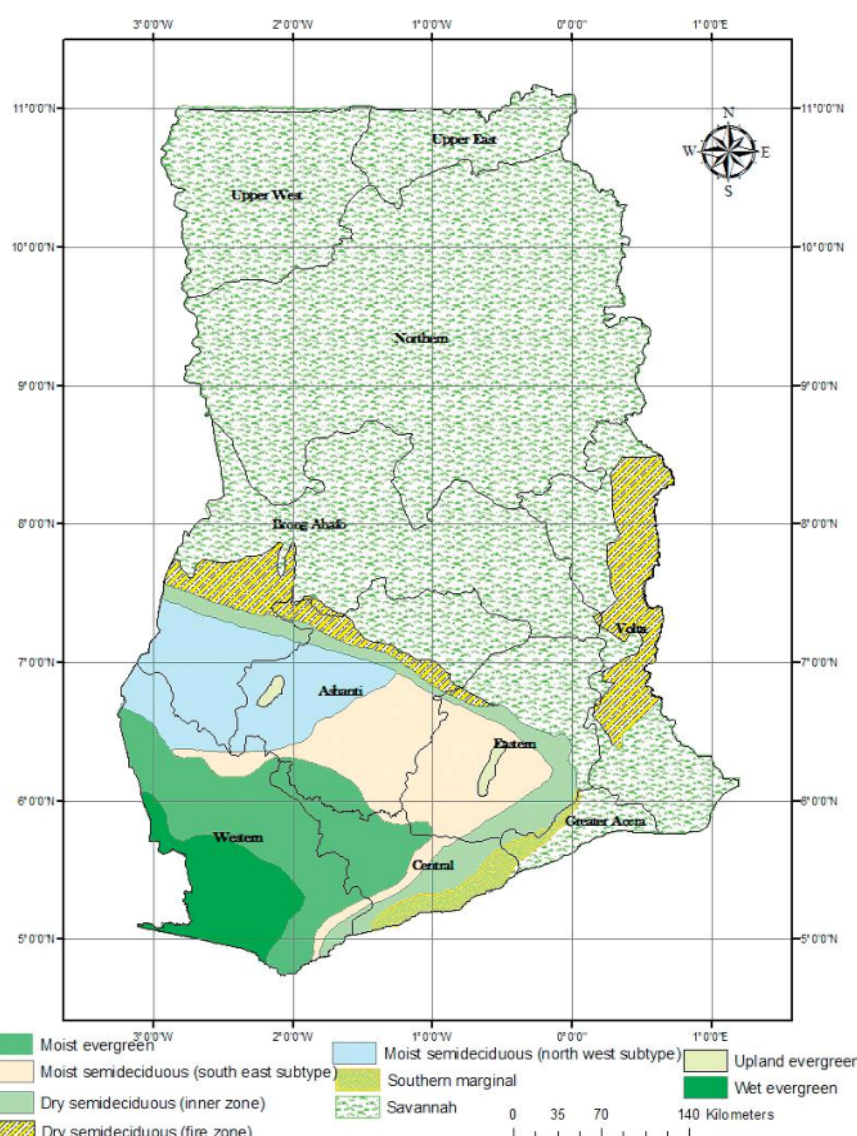
Figure 1. Map of Ghana showing the vegetation cover of high forest and savanna zones of Ghana. Source: Ghana’s high forests: trends, scenarios and pathways for future developments. Accessed on (https://www.semanticscholar.org/paper/Ghana’s-high-forests-%3A-trends%2C-scenarios-and-for-Oduro/56f6633ef23edbc1340f85365bf622c395ef533d) in July 2020.